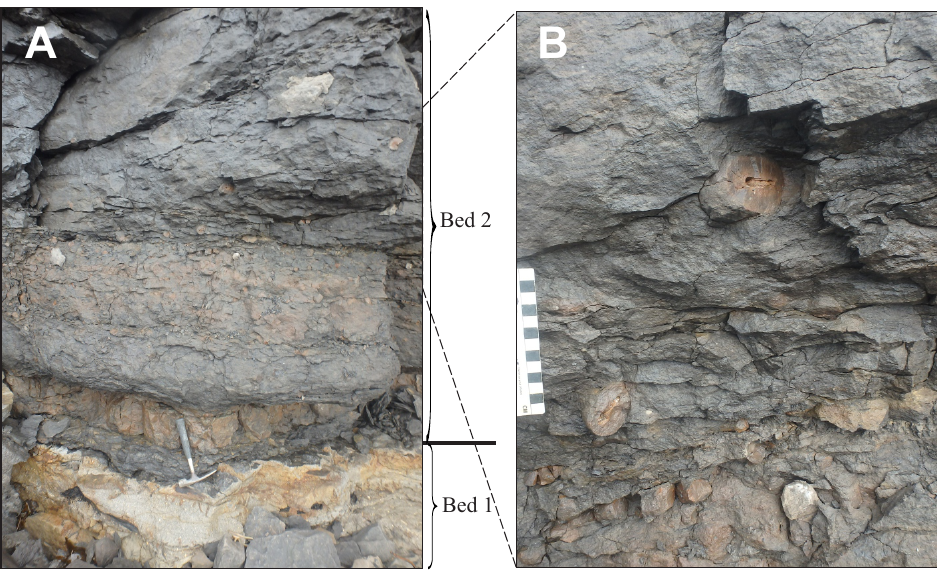
Figure 2. Close view of the studied section (A) and details of ammonite-bearing interval (B) with clearly visible ammonite moulds embedded in phosphorite